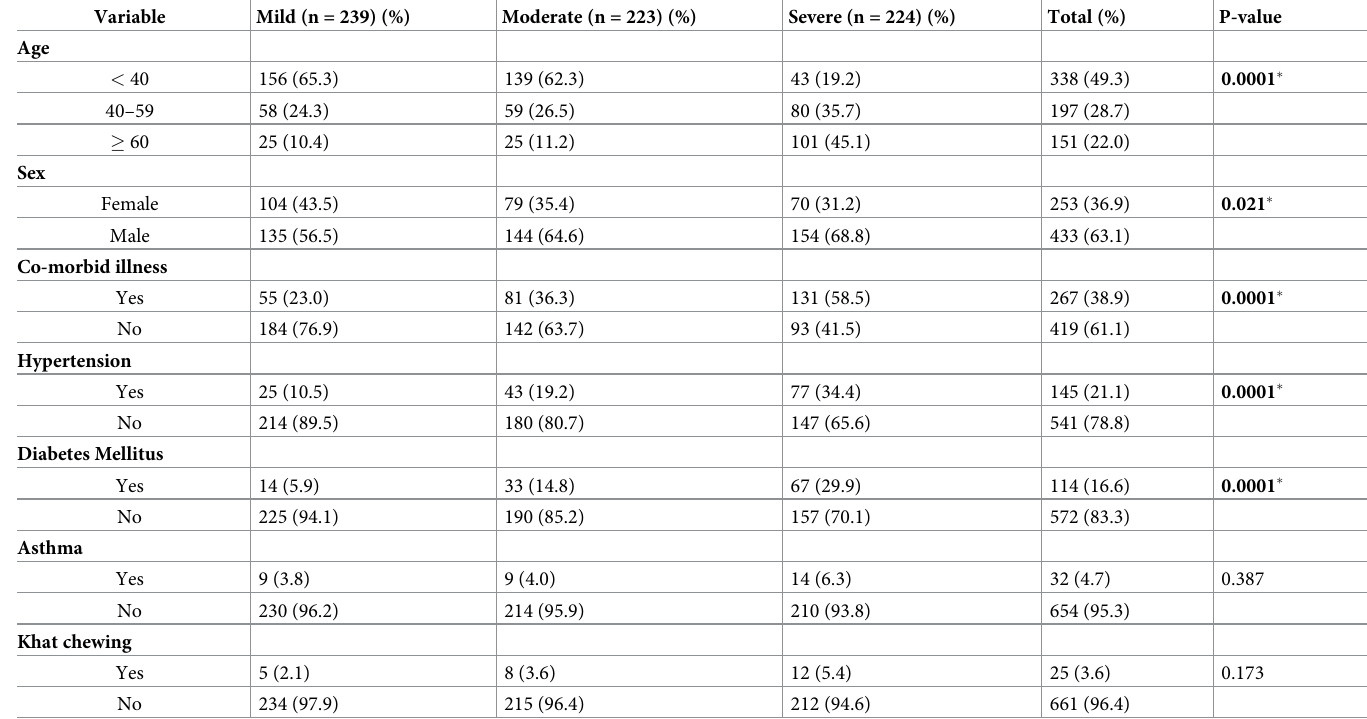
Table 1. Socio-demographic, co-morbid illness, disease related characteristics and comparison based on disease severity among patients (n = 686).